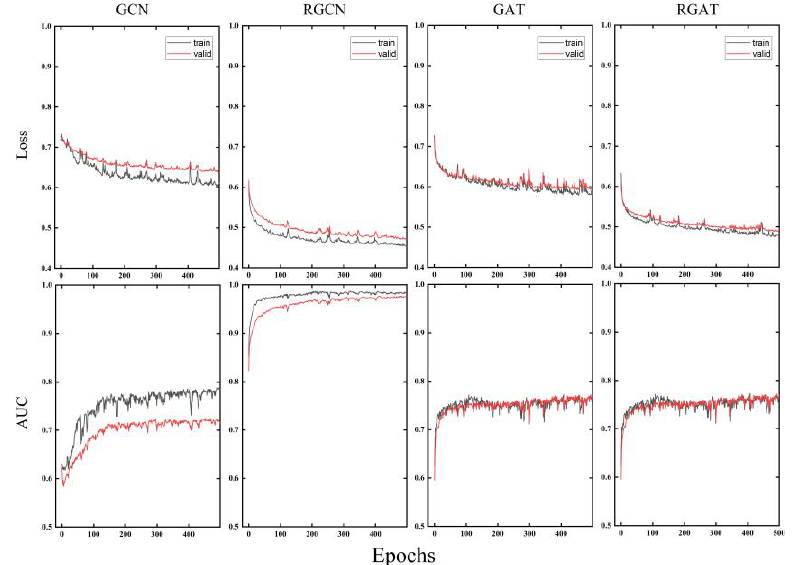
Figure 2. Loss and AUC of the four studied models varied by